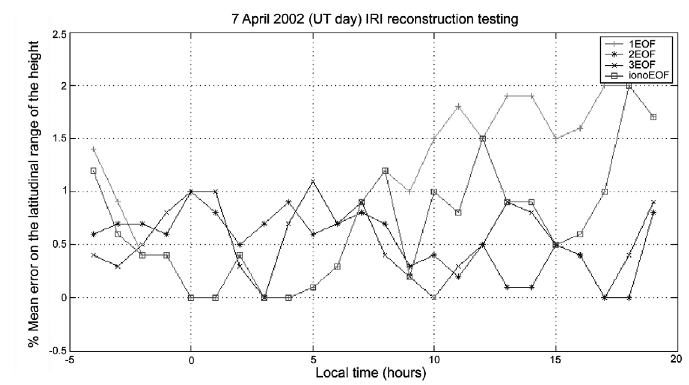
Fig. 3e. The errors on the reconstructions, defined as the difference between the quantity calculated for the model IRI ionosphere and for the MIDAS reconstructed one. The errors are plotted here as a function of local